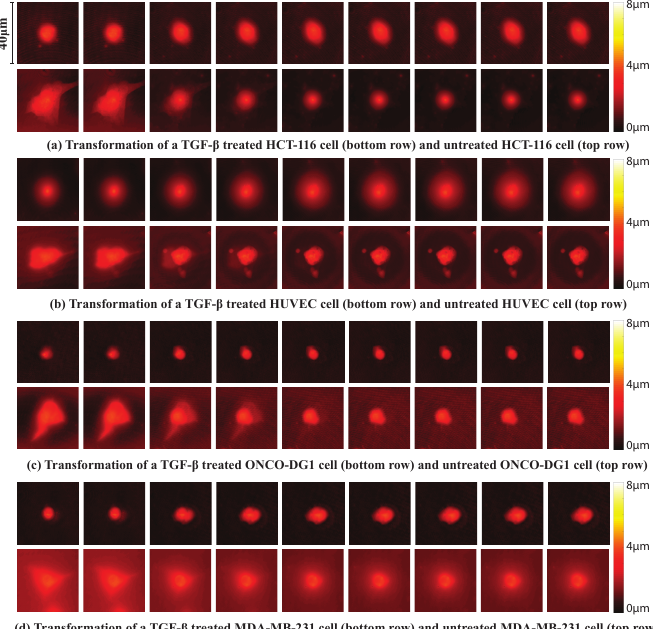
Figure 2. A reconstruction of the depth maps for each cell line throughout a 48 h period in 6 h intervals. This figure show exemplary depth maps from ( a ) HCT-116, ( b ) HUVEC, ( c ) ONCO-DG1, and ( d ) MDA-MB-231 cell lines for 0, 6, 12, 18, 24, 30, 36, 42, and 48 h intervals respectively from left to right. All units of the axis scales are in µ m. For each cell line, we observed a transformation to a more spherical shape, which indicates a decrease in the adherent characteristic of the cells. For each sample, A is the surface area of the cell in µ m 2 , h is cell height in µ m, and E is the eccentricity value which is